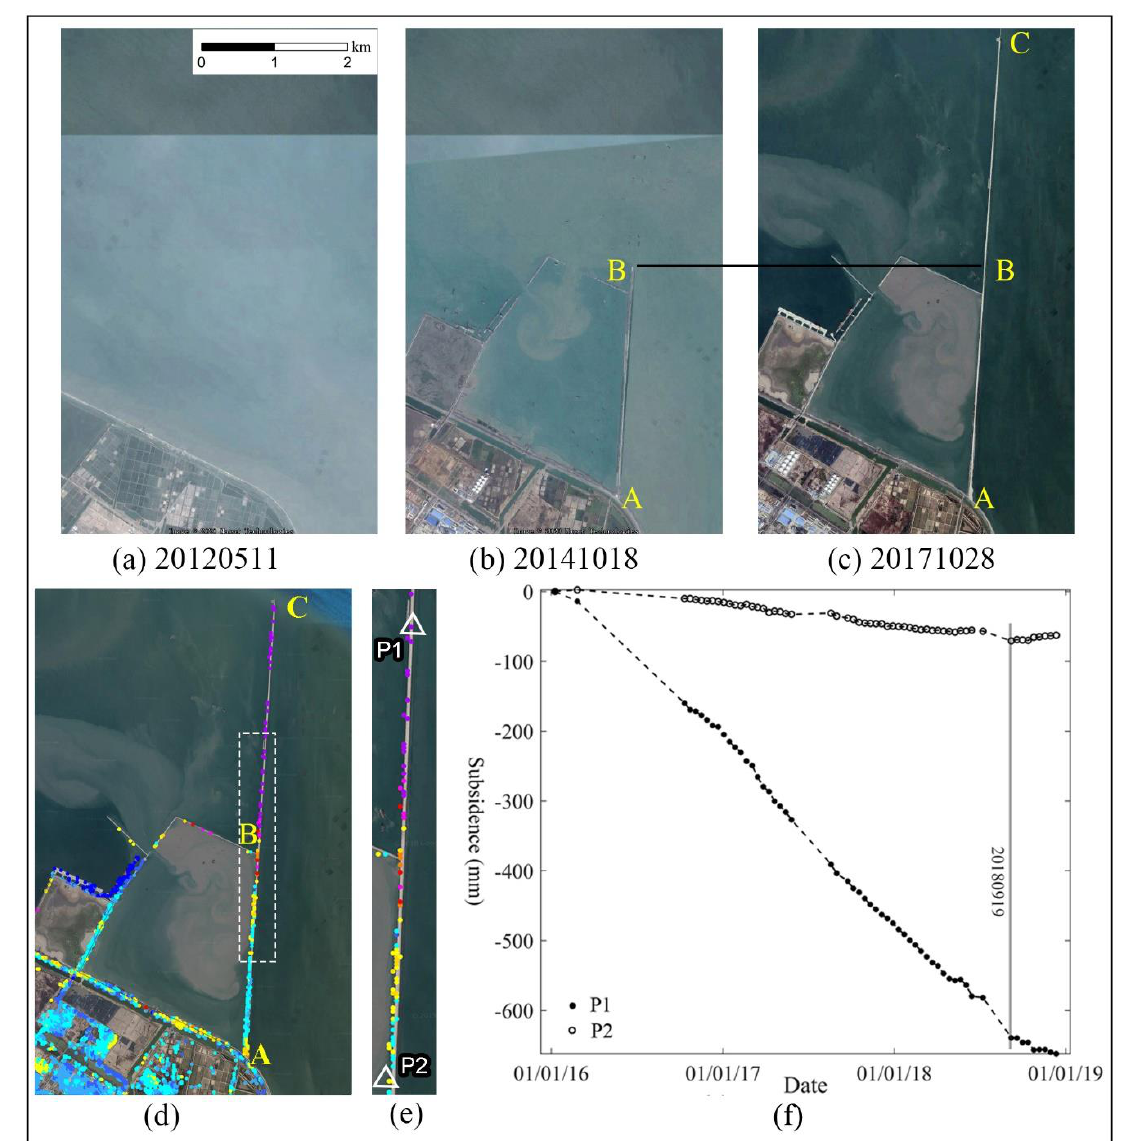
Figure 6. Subsidence in zone A of Figure 4. Optical images in May 2012, October 2014 and October 2017 are shown in ( a ), ( b , c ) respectively. Mean subsidence velocity of coherent pixels (CPs) are overlaid on the latest optical image in ( d ). The enlarged view of the dash-line rectangle area in ( d ) is shown in ( e ). The subsidence time series of two selected CPs: P1 and P2 in ( e ) are presented in ( f ).